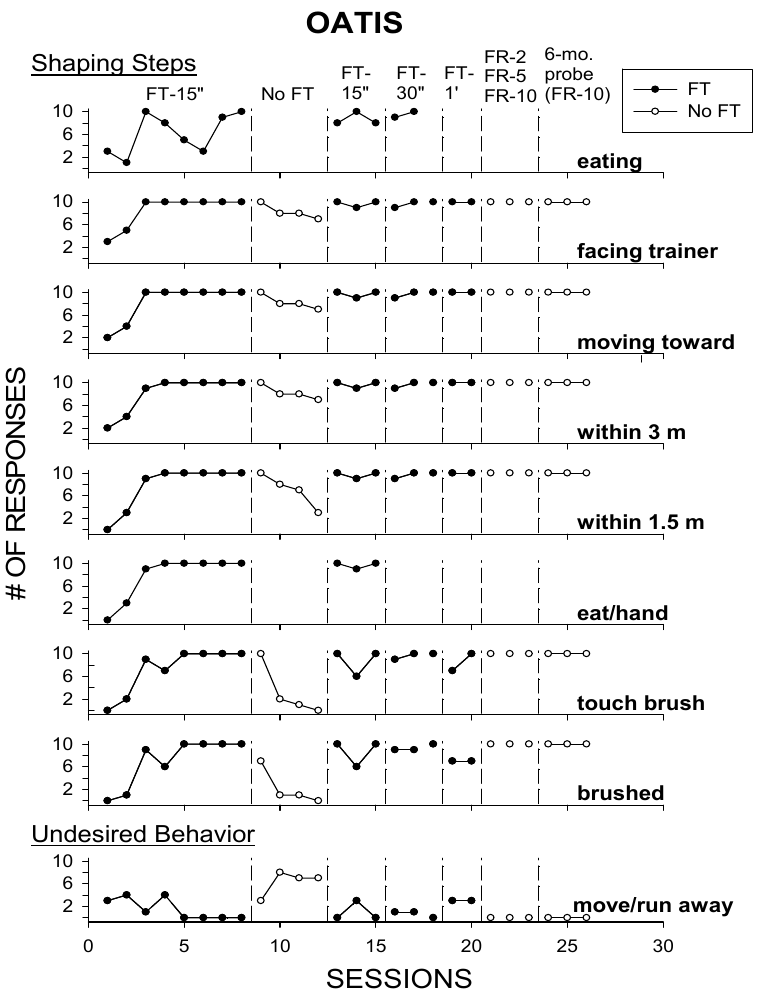
Figure 1. The number of responses for each step in the shaping procedure (top 8 graphs) and the undesired response (moving away; bottom graph) in Experiment 1. Closed circles represent when a Fixed ‐ Time (FT) food schedule was in effect, while open circles represent when no Fixed ‐ Time (No FT) food schedule was in effect. Fixed ‐ Time (FT) schedules of differing times and Fixed ‐ Ratio (FR) schedules of differing responses are listed at the top of the graph. The y ‐ axis shows the number of responses that occurred per session (out of 10 trials), and sessions are listed on the x ‐ axis.